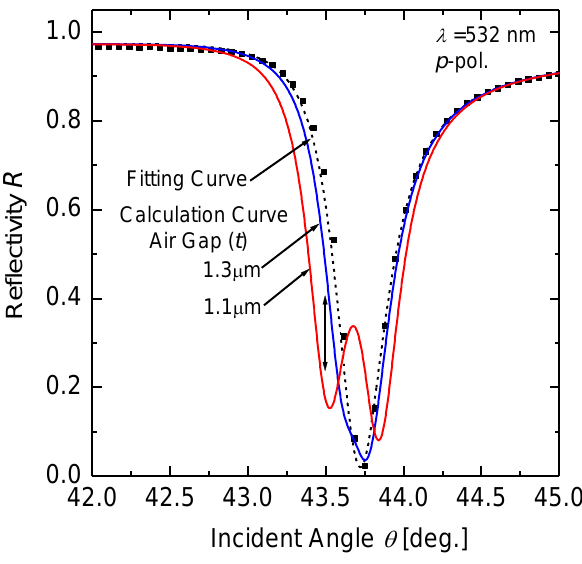
Figure 3. Typical effect of the air-gap distance change upon the reflection from the microcavity of a glass prism/Ag thin film/air gap/Ag. Solid curves represent the calculated reflectivity as a function of incident angle  for the air-gap distances of t = 1.1 and 1.3  m. The solid quadrangular symbols and the dotted curve respectively represent the measured ATR data at  = 532 nm ( p -polarized) for a thin Ag film ( d = 56 nm) and the Fresnel fitting